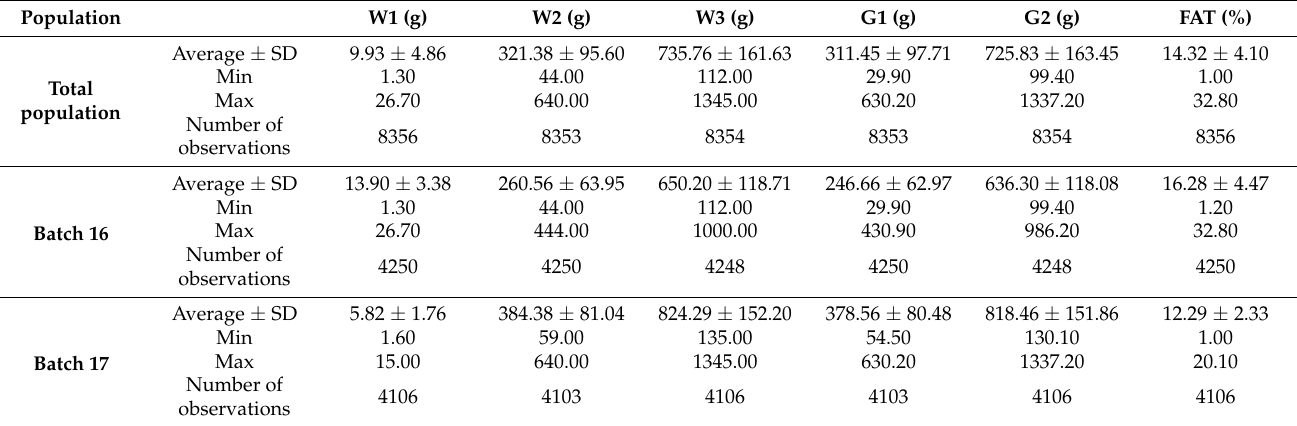
Table 2. Descriptive statistics of the